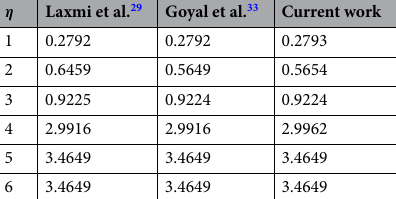
Table 2. Cssesment of the published work and present